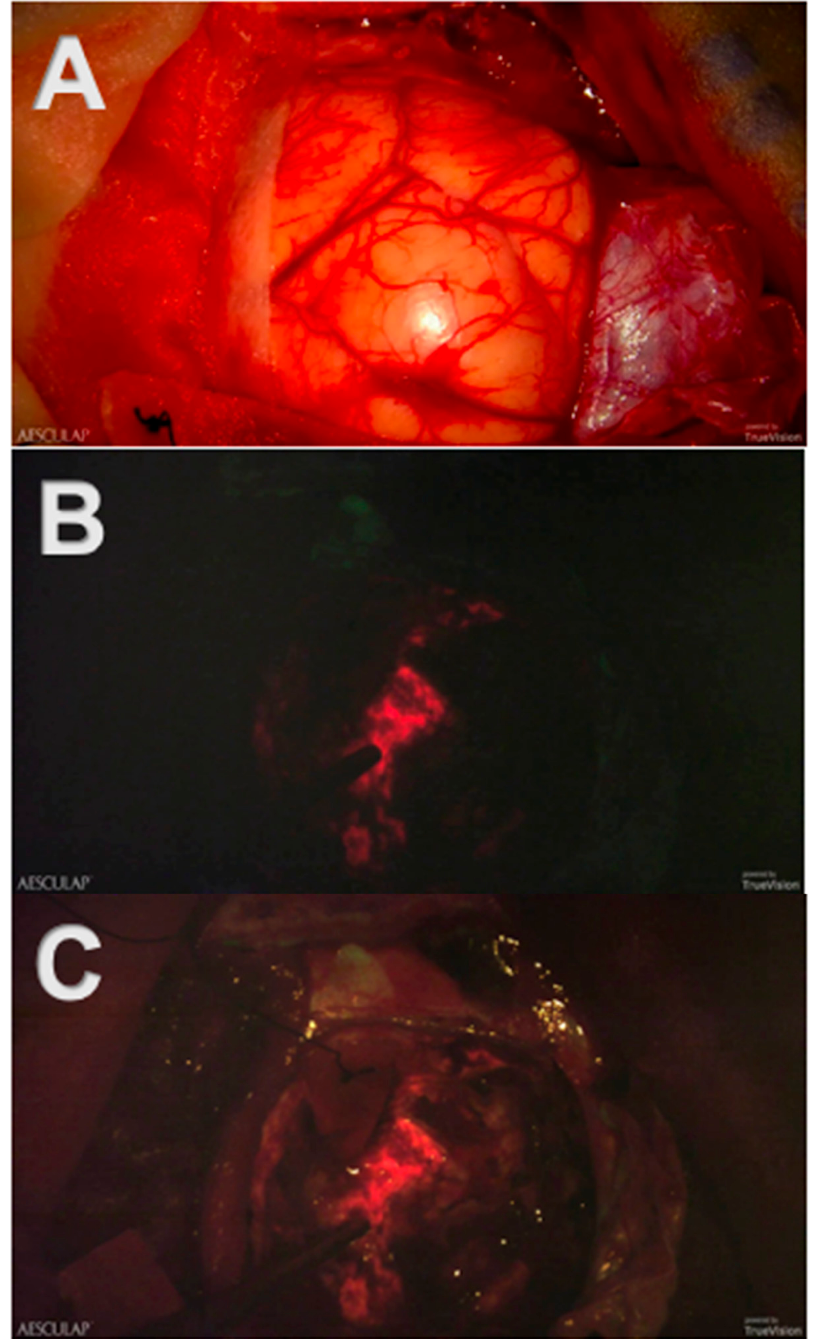
Figure 3. Screenshots of intraoperative recordings with Aeos during resection of a glioblastoma multiforme assisted by 5-ALA-induced PpIX fluorescence: ( A ) Conventional white light. The tumor and its margins are elusive under conventional white light. ( B ) Blue light. The tumor is clearly visible in strong fluorescence under dimmed white light and activated blue light. ( C ) Simultaneous usage of the white and blue light source: Tumor margins are easier to identify.